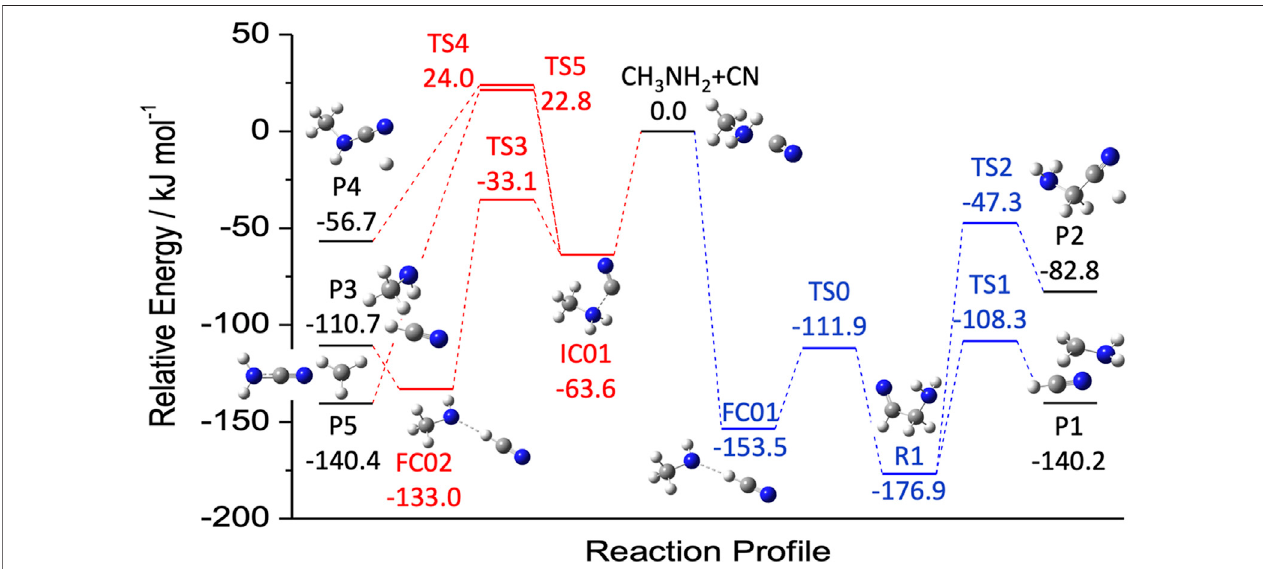
FIGURE 5 | Reaction mechanism for the attack of CN to the N (red) and C (blue) moieties of methylamine. Energies, from Puzzarini et al. (2020), were evaluated using a coupled-cluster based composite scheme (the so-called ‘ HEAT-like ’ ) and augmented by anharmonic zero-point energy